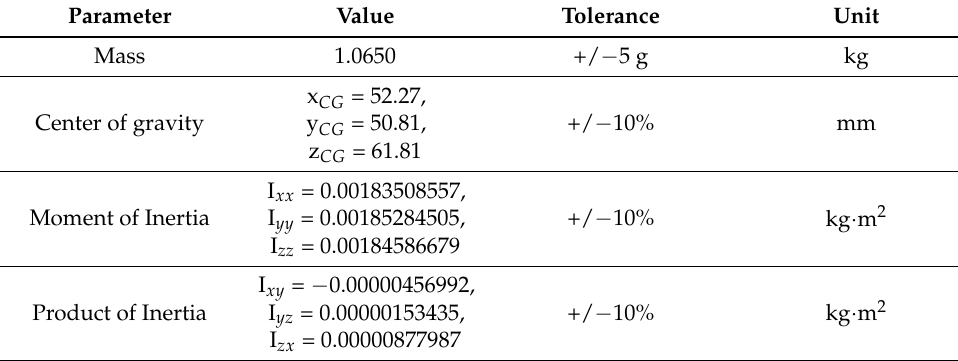
Figure 3. AlfaCrux CAD isometric view. Table 1. AlfaCrux mass properties.